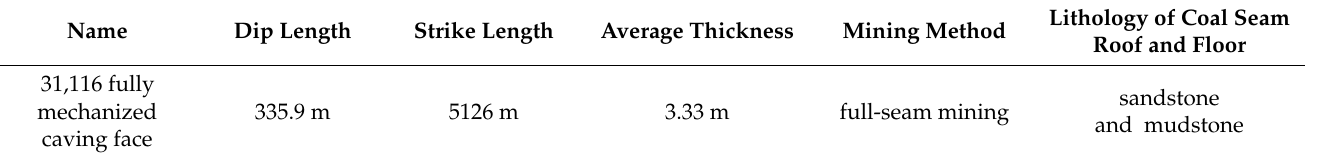
Table 1. Working face parameters (own